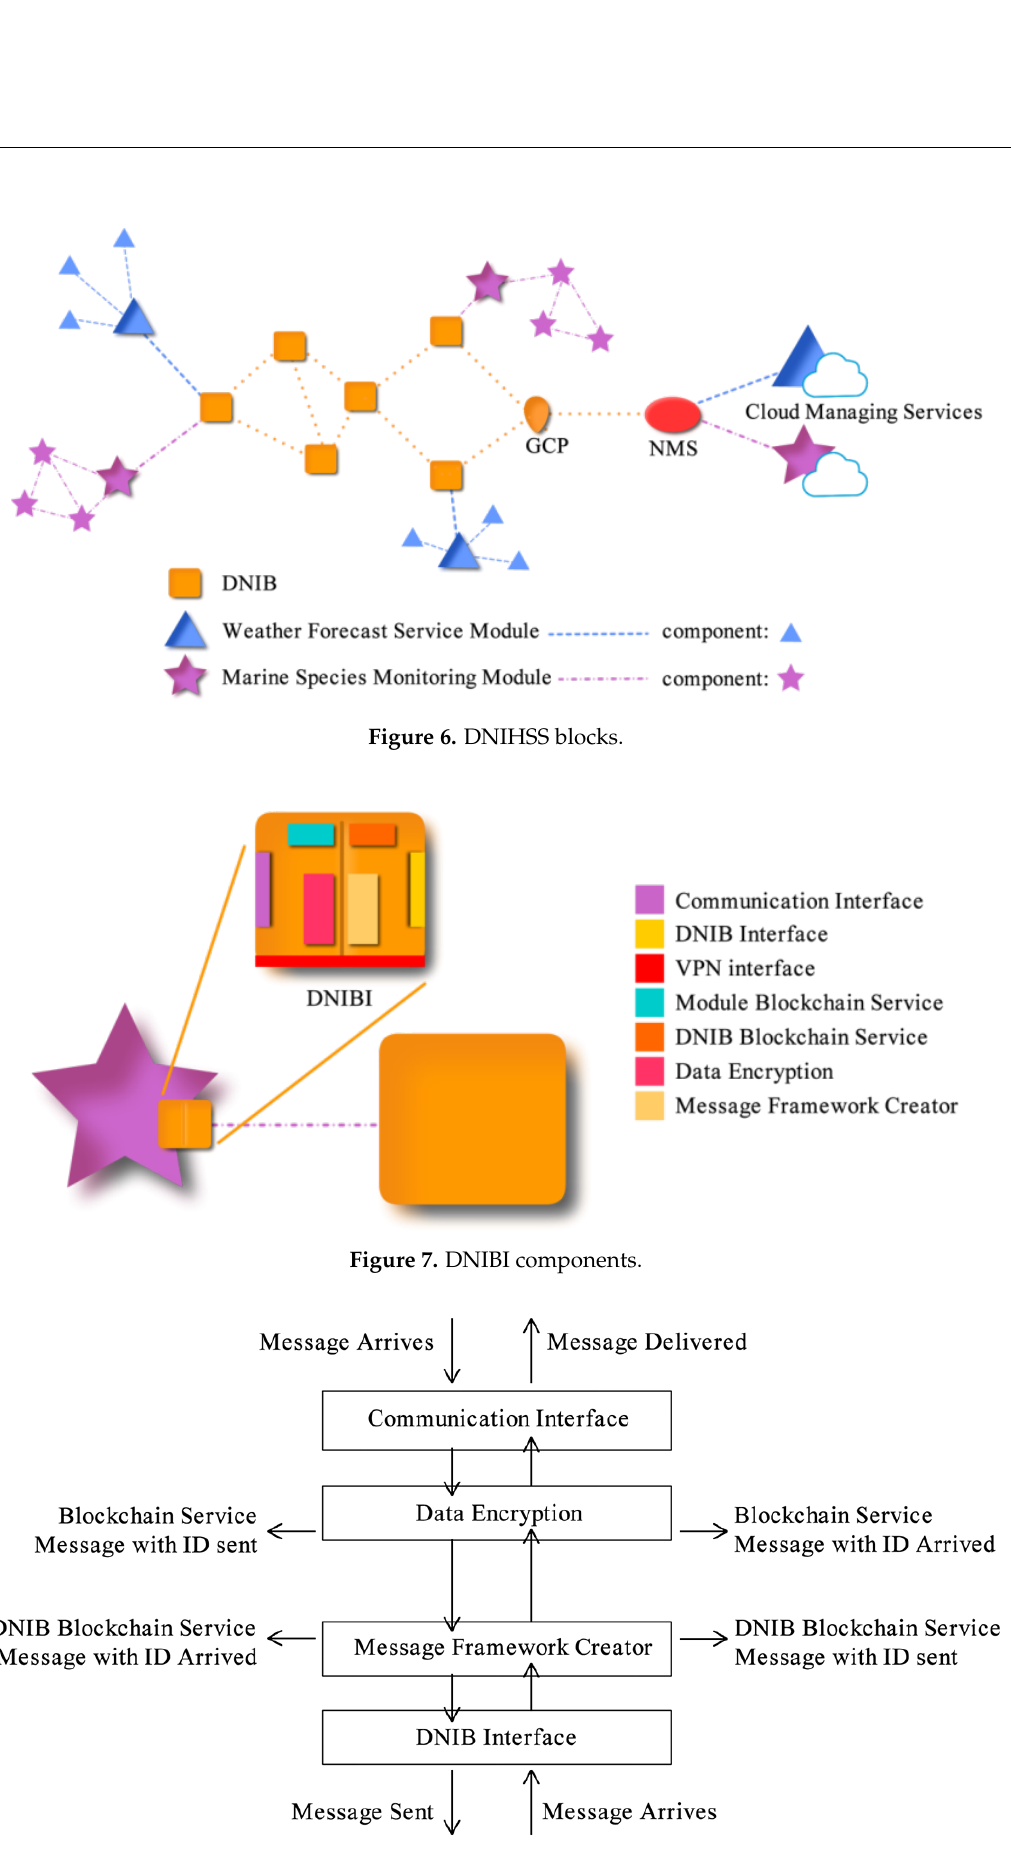
Figure 8. DNIBI flow of the asynchronous data exchange commands.